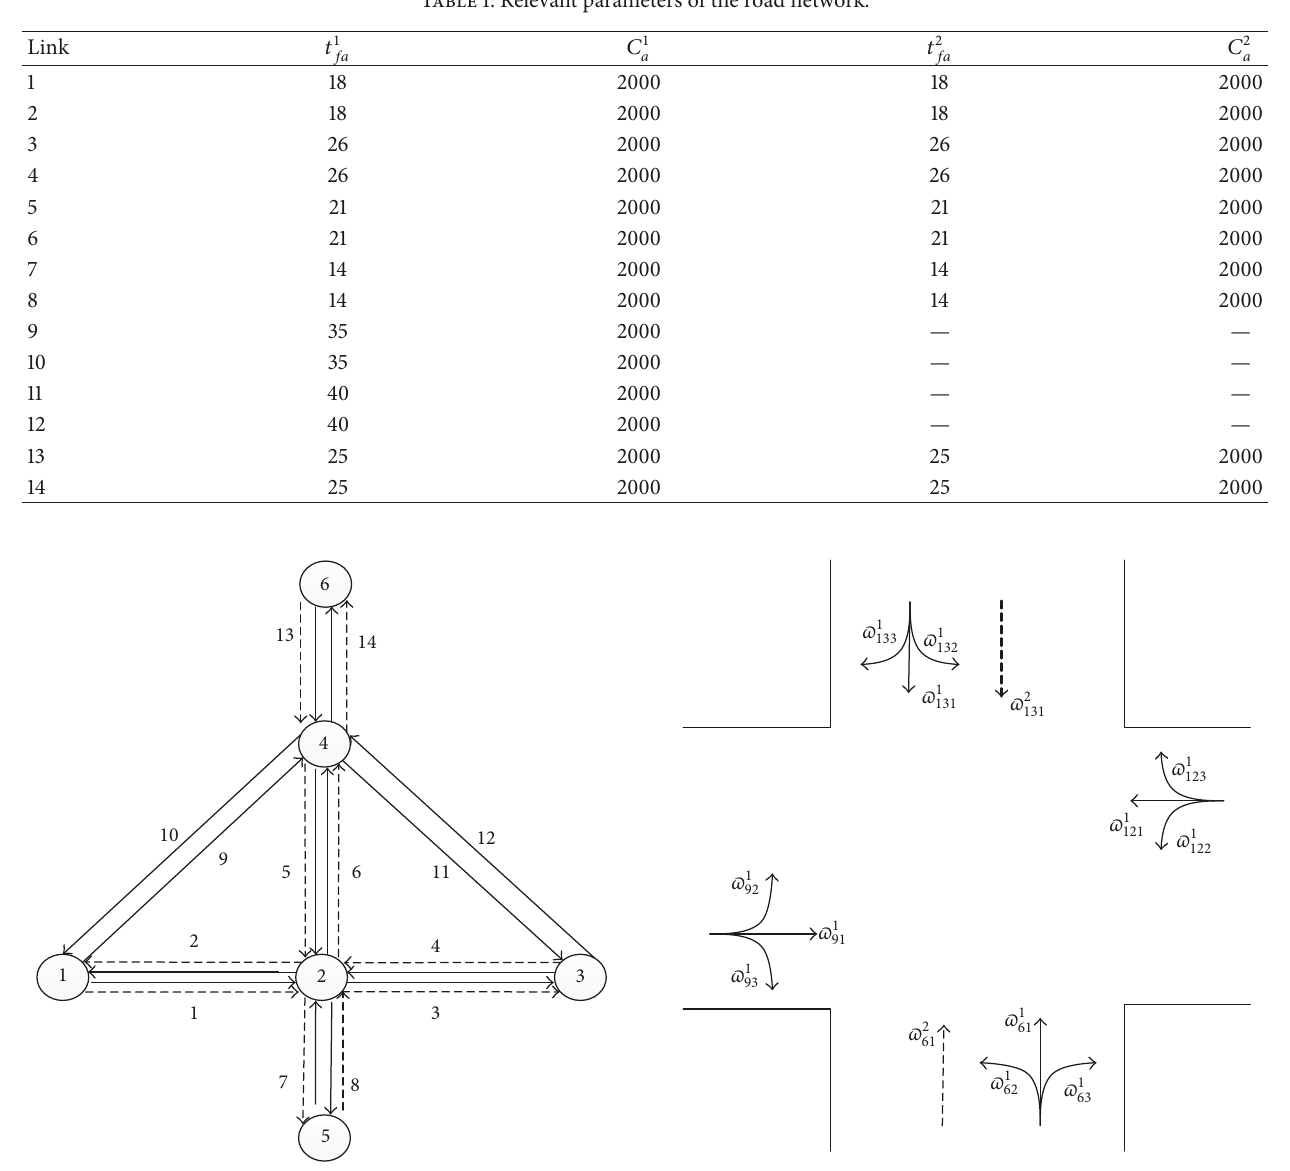
Table 1: Relevant parameters of the road network.